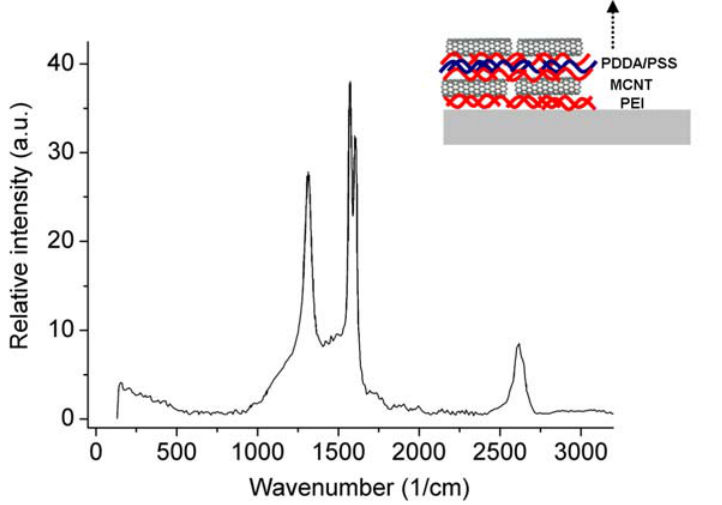
Figure 6. Raman spectrum of films containing polyelectrolyte multilayers with multilayer MWCNTs; the inset shows schematics of the formation of such